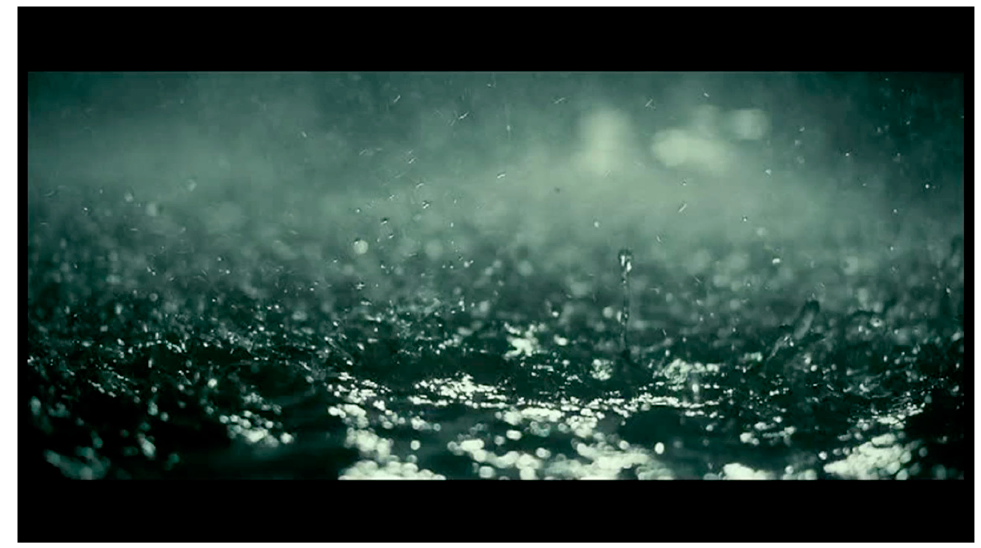
Figure 6. Particles that drift, particles that drive. Frame capture, The Grandmaster (Wong 2013). The body punches the pavement, streaking, pounding, striking, beating. Another axis, crashing against the upright human bodies and those that skid across the ground. The body of water punches the ground as the human bodies block, throw, lunge—two axes of action in the frame that ricochet off each other. It is unclear whether the driving, splashing rain registers the impact of the fighters’ bodies or vice versa. The rain enmeshes the fighters in a web of materiality: air/space become visible, dense (Figures 7–10).